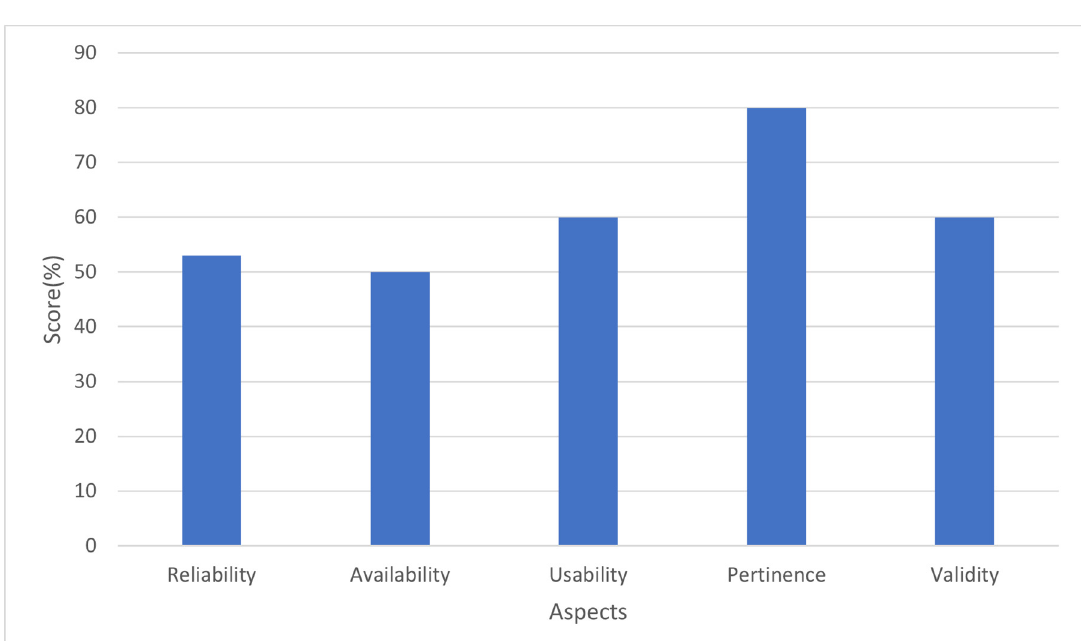
Figure 7. Data Quality Aspect Scores.